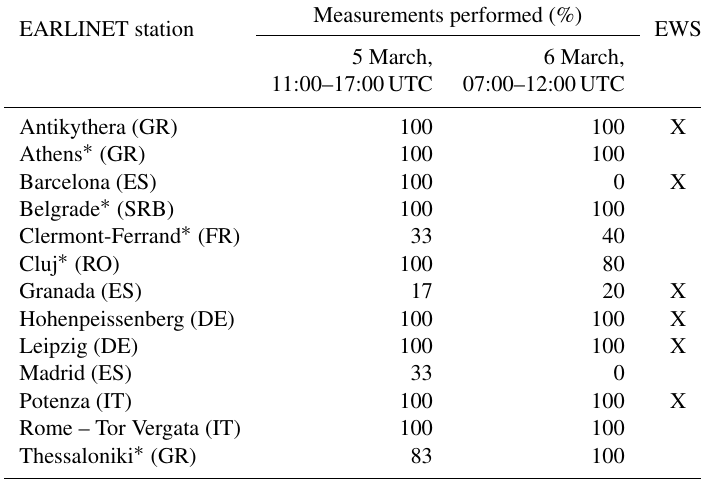
Table 2. EARLINET stations that participated in the EUNADICS-AV exercise during 5–6 March 2019. The percentage of the measurements made for the 2 consecutive days and the specific temporal windows is reported. The “X” denotes the stations for which it was possible to derive the alert for aviation – i.e., the availability of a calibrated backscatter coefficient and depolarization ratio of 532nm.